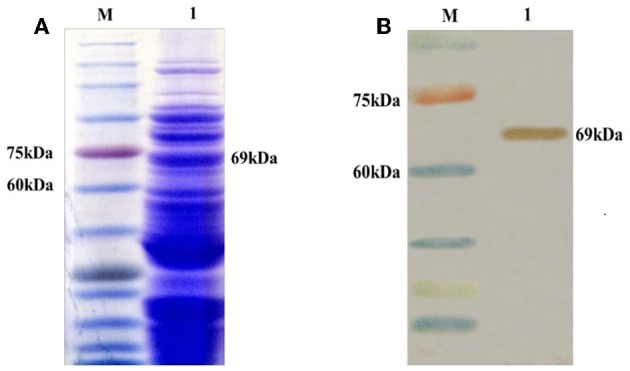
Identification of the recombinant pgsA-gp85 protein (unpurified) expressed in L. plantarum (pMG36e) by SDS-PAGE (A) and Western blot (B). M: protein marker; 1: the pgsA-gp85 protein predicted as 69 kDa.